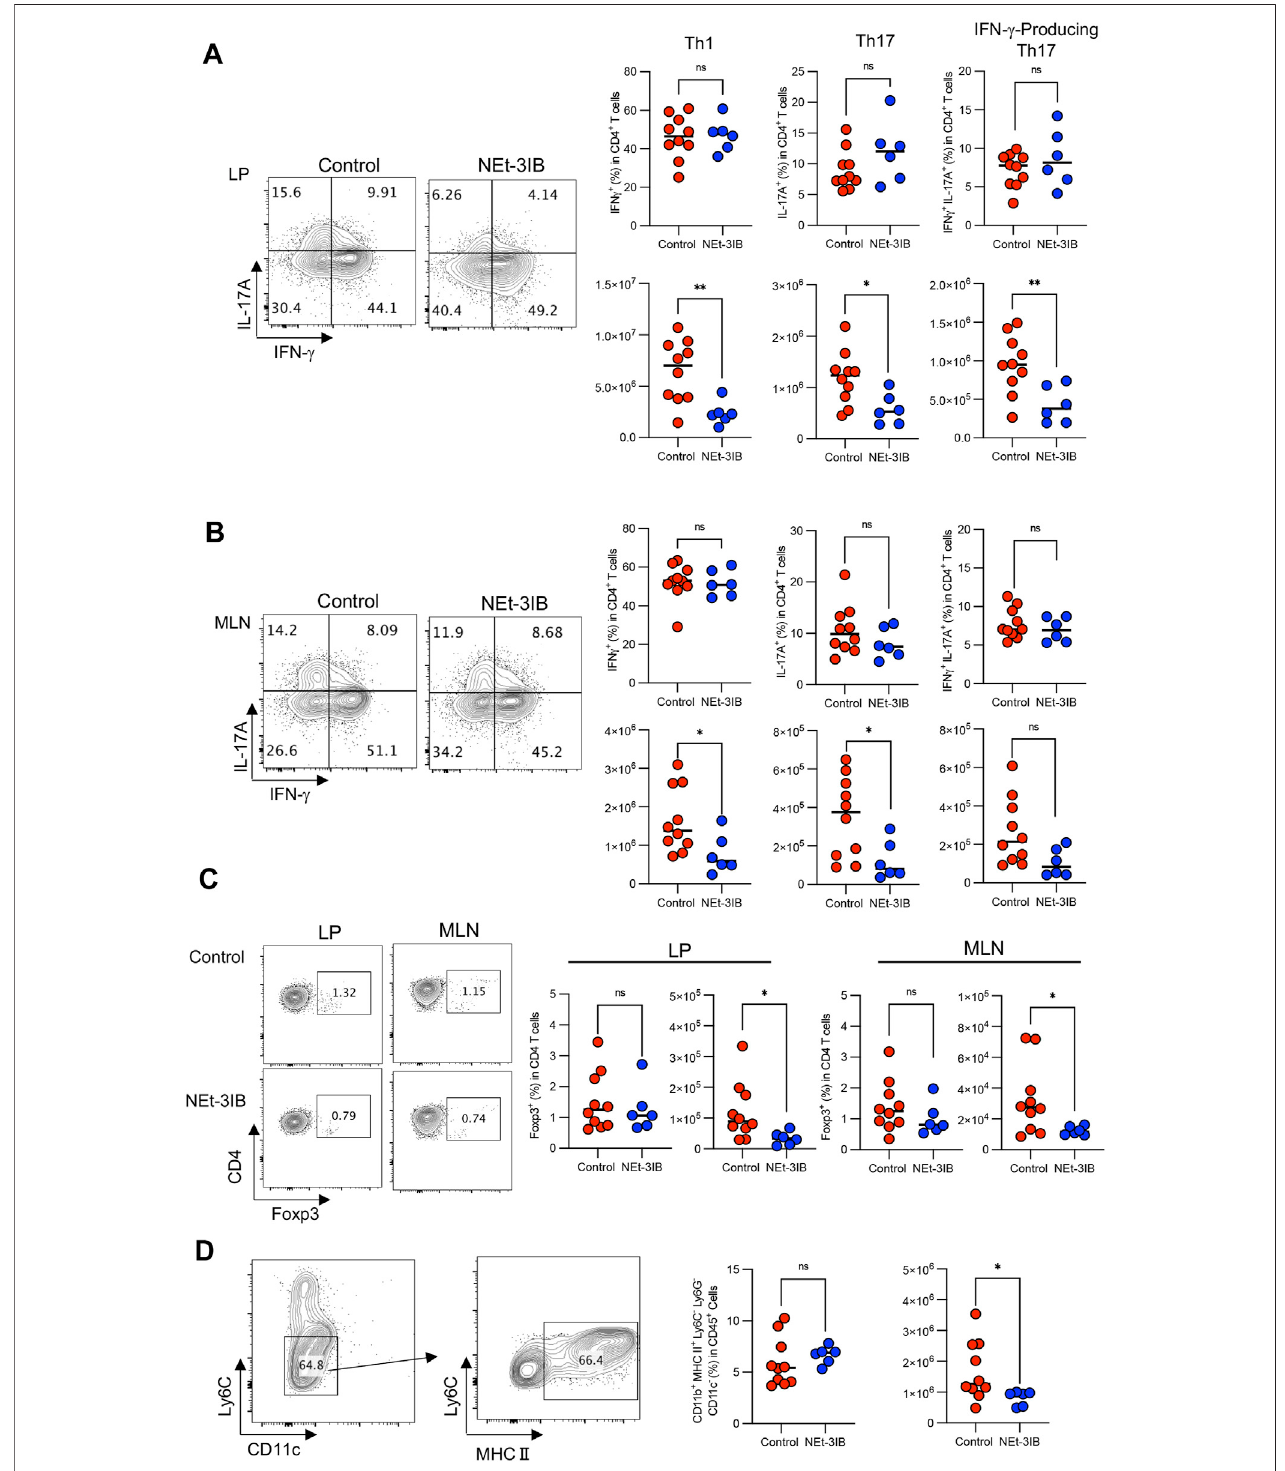
FIGURE 3 | NEt-3IB inhibits in fl ammatory T cells. (A) Frequency and cell number of IFN- γ -producing cells and IL-17A-producing cells in the colon lamina propria. (B) Frequency and cell number of Th1 transcription factor T-bet and Th17 transcription factor ROR γ t-presenting cells of the colon lamina propria and mesenteric lymph nodes. (C) Frequency and cell number of Foxp3 + regulatory T cells in the colon lamina propria and mesenteric lymph node of T cell-transferred SCID mice. (D) Macrophages were gated as CD11b + Ly6G − Ly6C − CD11c − MHC2 + . The right-hand graphs show the frequency of macrophages in CD45 + cells and the number of macrophages. (A – D) are from CD45RB high T cell transfer model mice at 7 weeks post-transfer.